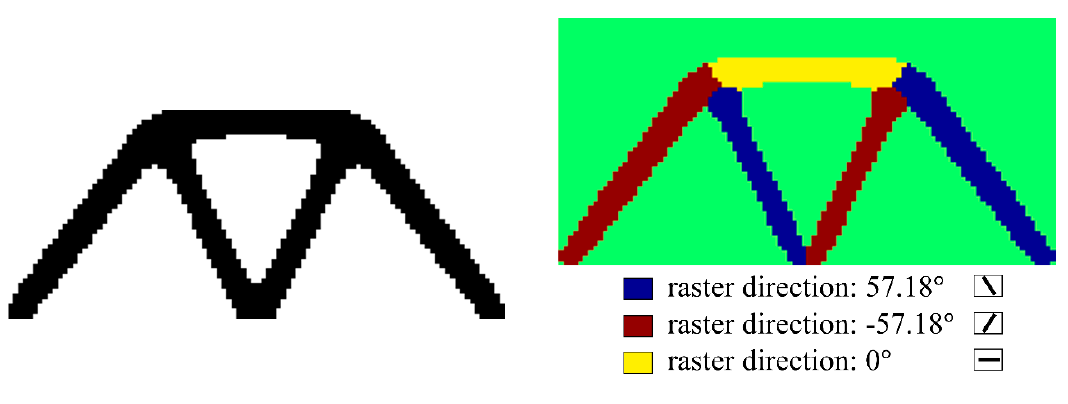
Figure 10. Structure optimization results (the blue color shows the converged ρ e 1 = 1 , the red color shows the converged ρ e 2 = 1 , the yellow color shows the converged ρ e 3 = 1 , and the green color shows the misconverged or void areas).